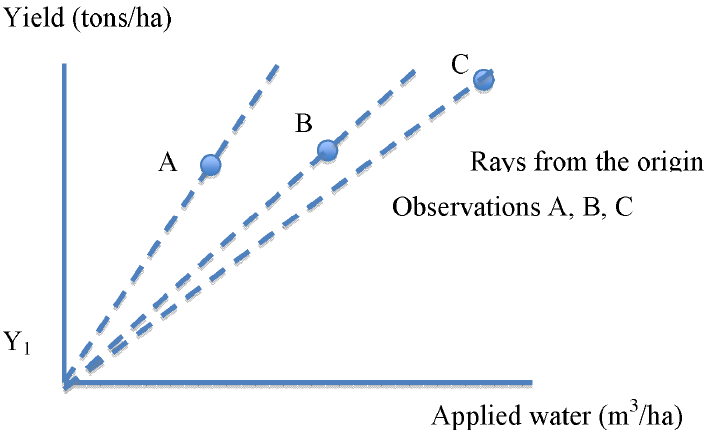
Figure 6. Comparing observations of water productivity, with respect to applied water.